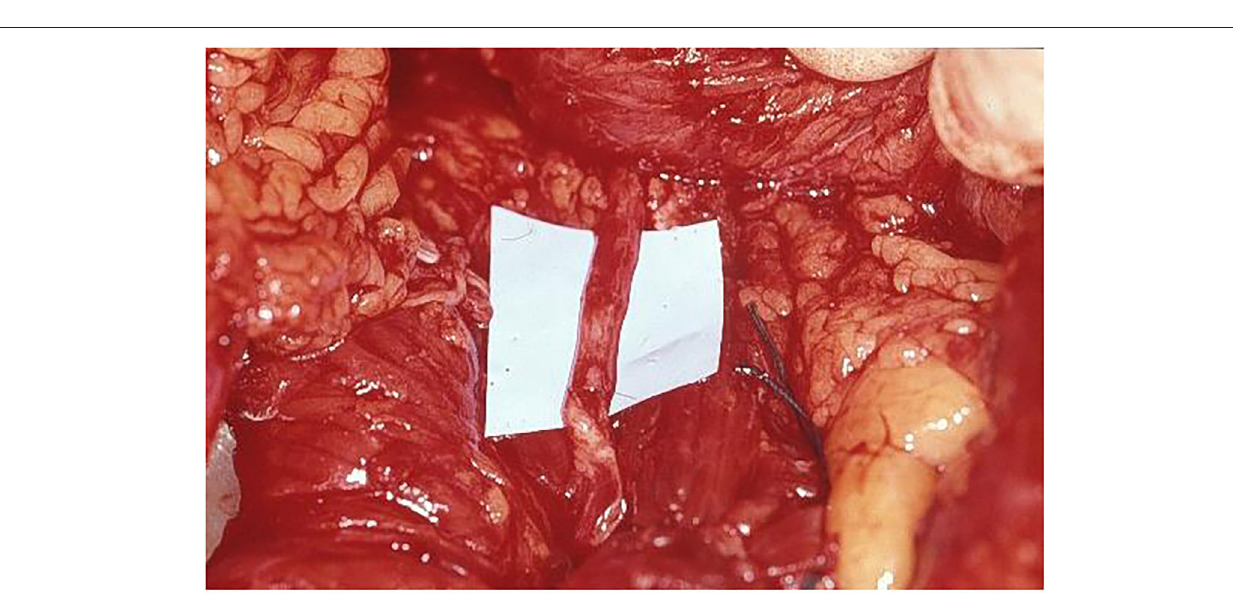
morbidity, and lack of controlled abdominal wall